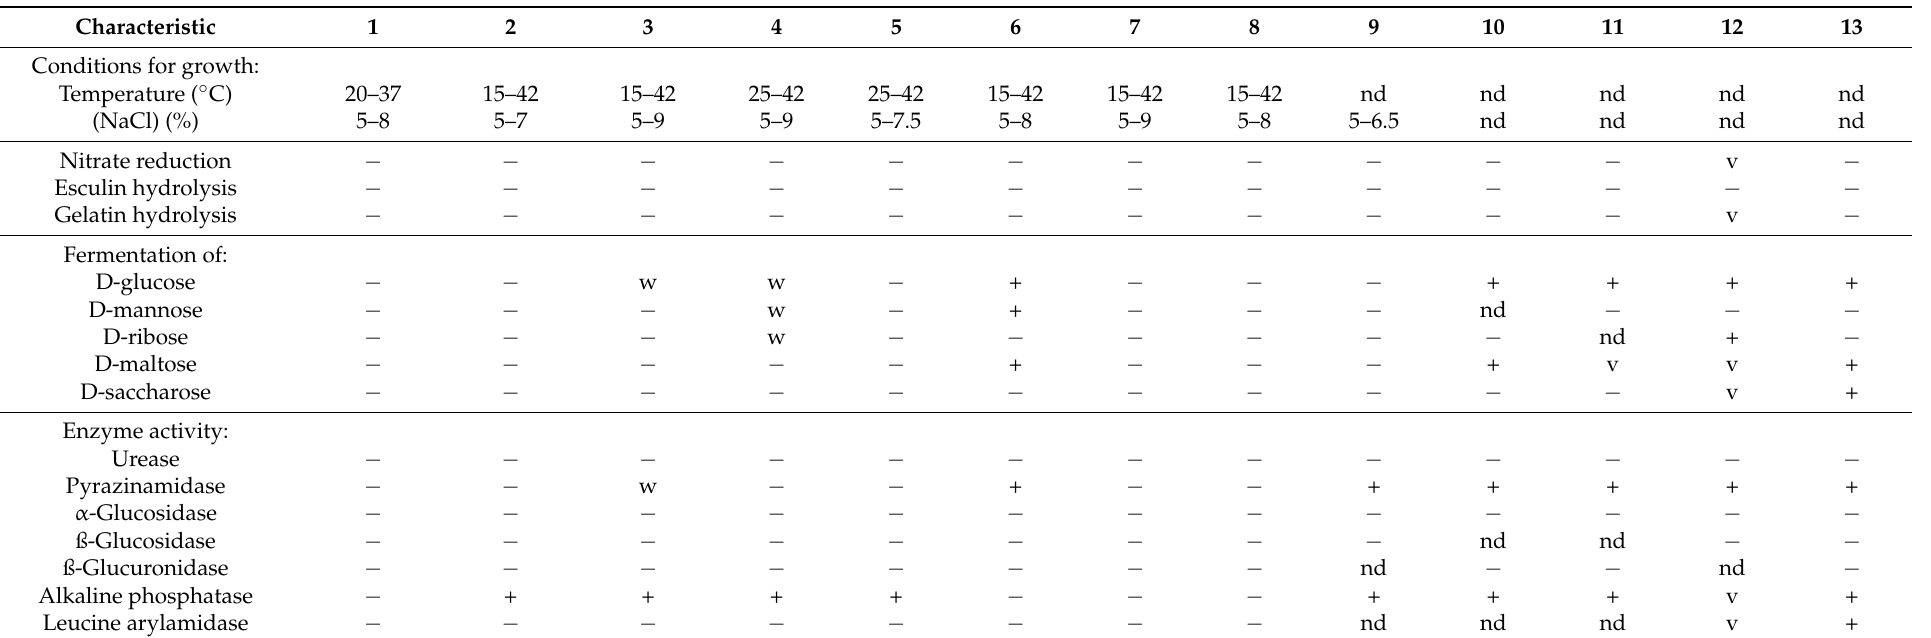
Table 2. Differential characteristics of the strains analyzed in this study and related type strains of Corynebacterium species. Strains: 1, c8Ua_144; 2, c8Ua_172;